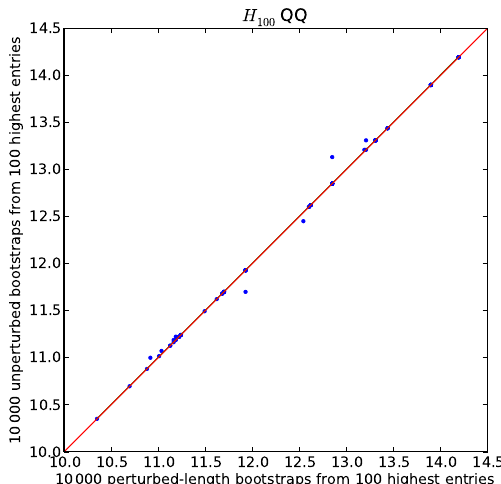
Figure 4. A quantile–quantile (QQ) comparison of M = 10000 bootstraps e D 1 , e D 2 ,..., e D M of variable length e K 1 , e K 2 ,..., e K M against bootstraps of fixed length K 0 , all from the upper 100 en- tries in the original sequence D 0 . The difference is very